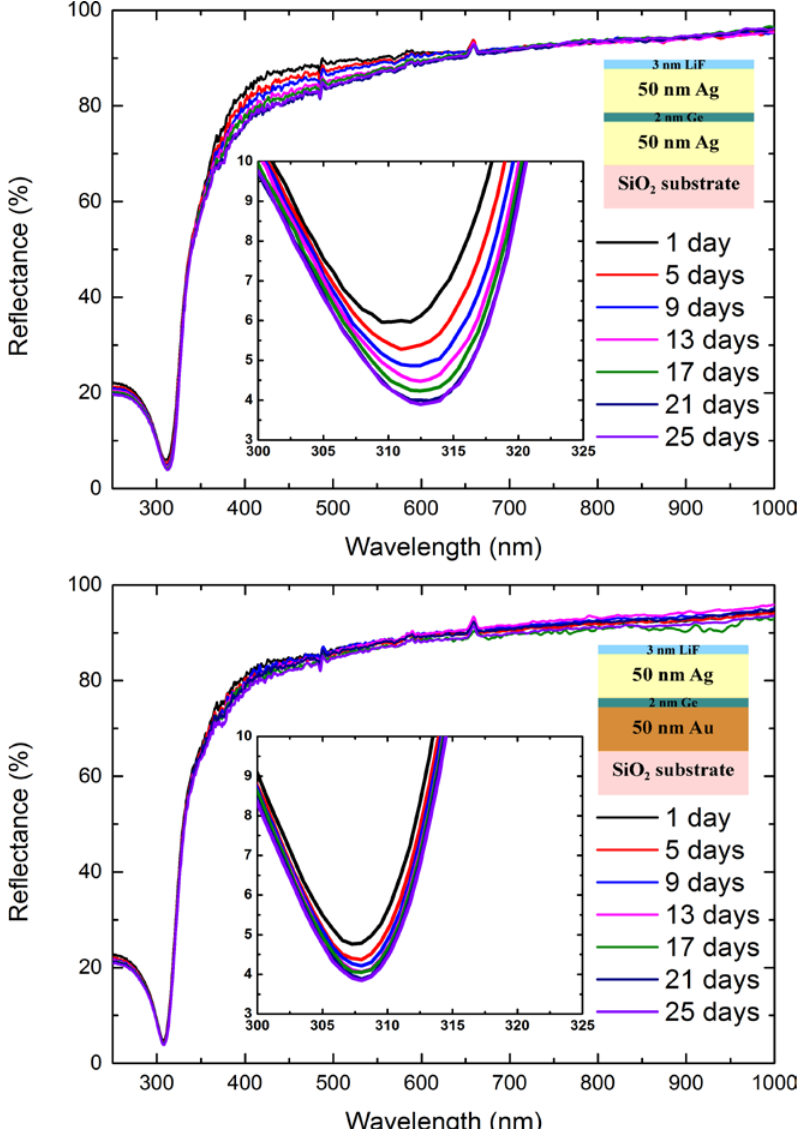
Figure 3. Reflectance spectra of sandwich-like structures where 2-nm-thick germanium film is deposited in between two 50-nm-thick Ag layers ( top ), and when the bottom Ag layer is replaced with Au ( bottom ). The insets present the enhanced fragment of the main graphs. The small kinks at 487 and 659 nm are measurement artifacts.